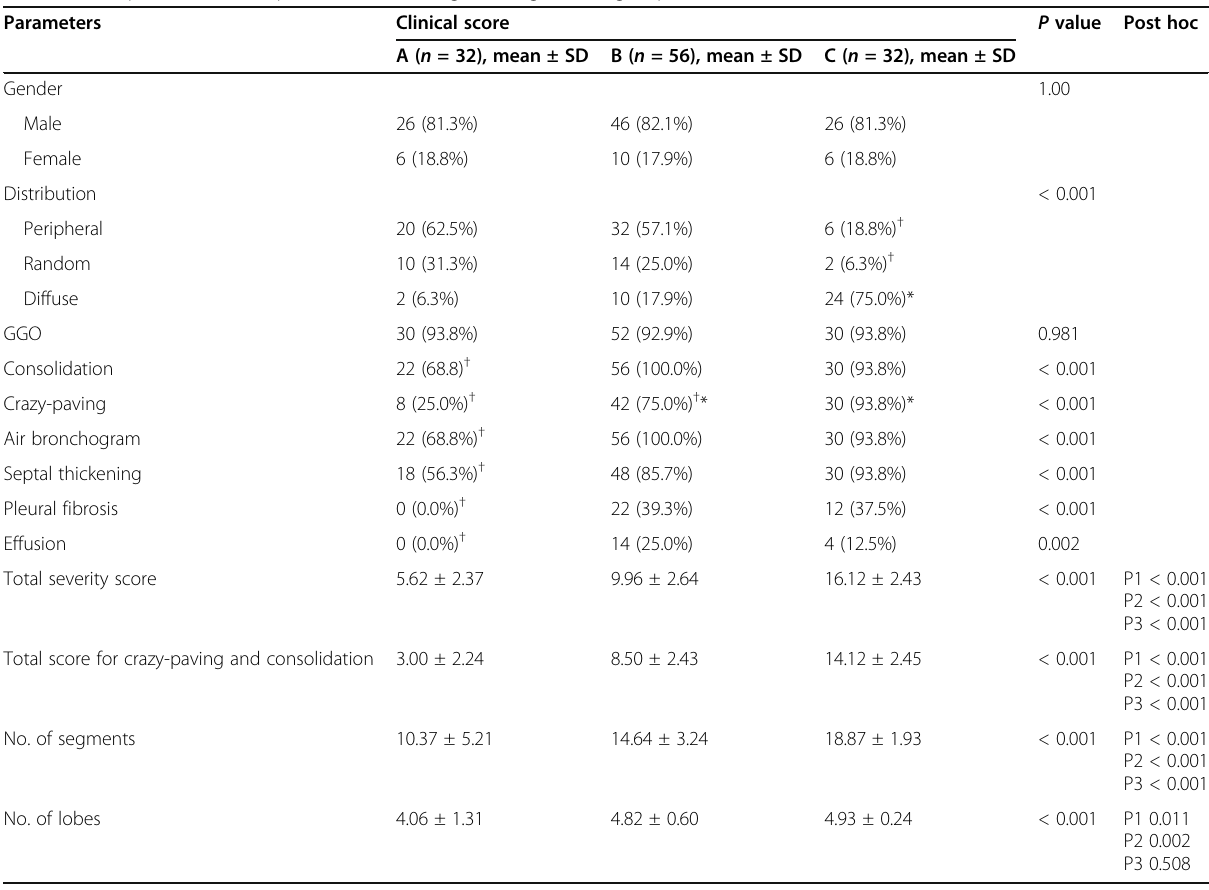
Table 1 Comparisons of the qualitative CT findings among clinical groups